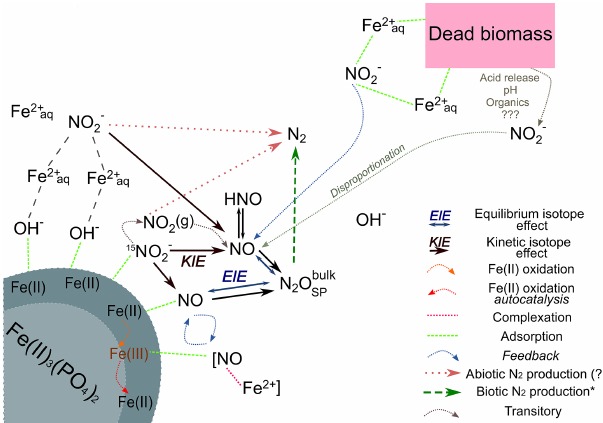
Figure 8. Conceptual figure depicting the proposed reaction mech- anisms and feedbacks between the different N species during chemodenitrification induced by the presence of a mineral surface (lower left corner) or (dead) biomass (upper right corner). Adsorp- tion of Fe 2 + (directly or via complexation by OH − ) as well as NO − could catalyse a direct reaction between both. In addition, 2 NO − adsorption onto the Fe(II) mineral might also induce dispro- 2 portionation, leading to NO x formation. These formed intermedi- ates, although transitory, may impact the overall reaction dynamics by processes such as complex formation (i.e. [NO–Fe 2 + ]) or di- rect Fe(II) oxidation. The Fe(III) produced might induce another feedback loop (autocatalysis), resulting in further Fe(II) oxidation. Similar processes are possibly induced by the presence of (dead) biomass. The adsorption and complexation of either NO − or Fe 2 + 2 would enhance the reaction between both. In addition, the presence of organic acids would decrease the pH locally, thereby promoting and accelerating NO − disproportionation and, thus, additionally en- 2 hancing Fe(II) oxidation. Our results suggest that NO − reduction 2 results in a KIE, which should influence the isotopic composition of NO. Here, N 2 O is an intermediate, the isotopic composition of which is mainly influenced by an EIE between NO and N 2 O. The low N 2 O yields and the N 2 O isotopic results (bulk and SP) clearly suggests that N 2 is produced